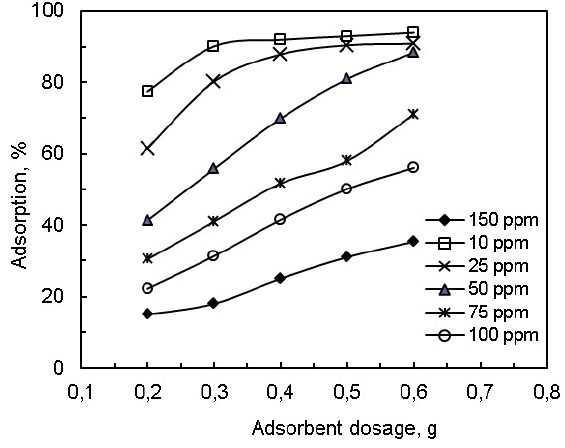
Fig.2. Effect of adsorbent dosage on different dye